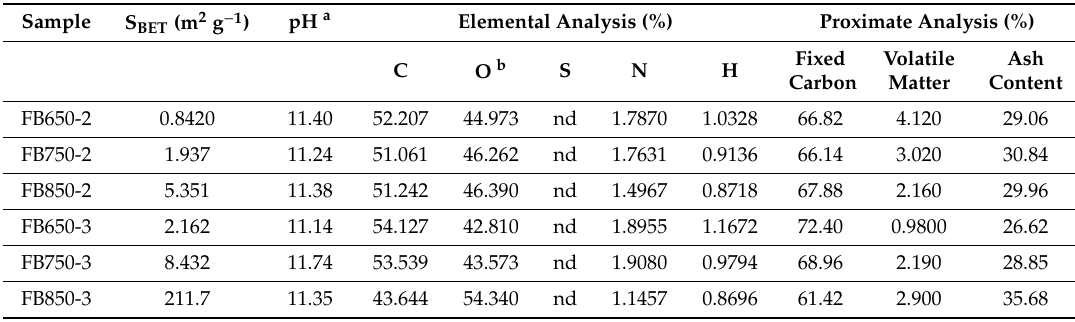
Table 1. Brunauer, Emmett and Teller surface area (SBET) and elemental analysis of the obtained fique bagasse (FB)